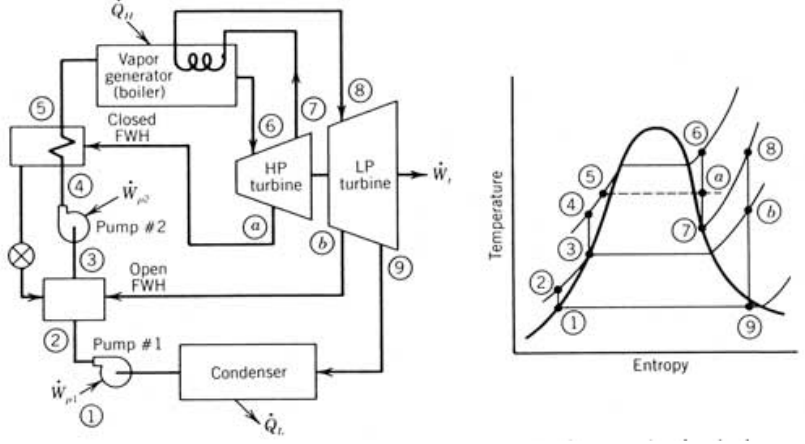
Figure 2. A Rankine cycle incorporating reheat and regeneration feed-water heating (modified from